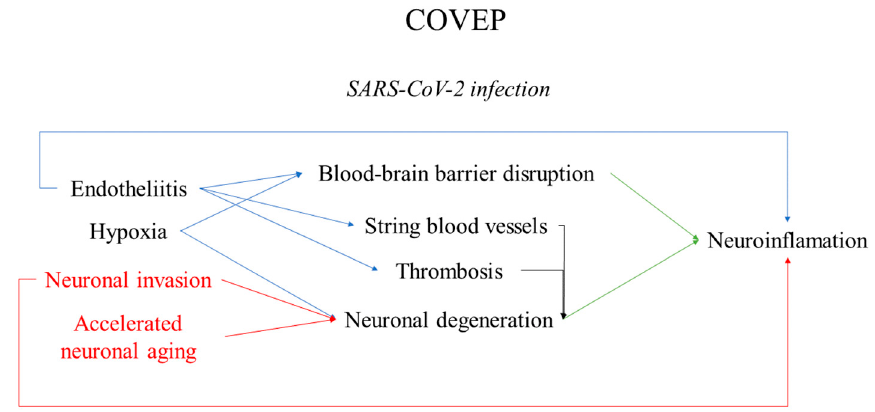
Figure 2. Mechanisms of neurological damage associated with COVID-19—COVEP; red denotes disputed mechanisms.